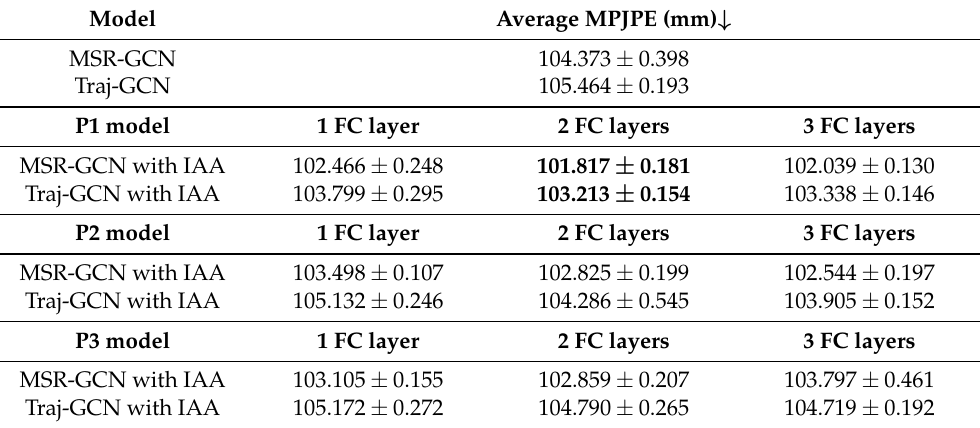
Table 2. Avarage MPJPE of 5 trials and its standard deviation on the NTU RGB+D 120 dataset. P1, P2, and P3 are the position where IAA is inserted in the GCN-based model, as described in Section 4.1. ↓ indicates that the smaller the value, the better. The bold indicates the best scores.